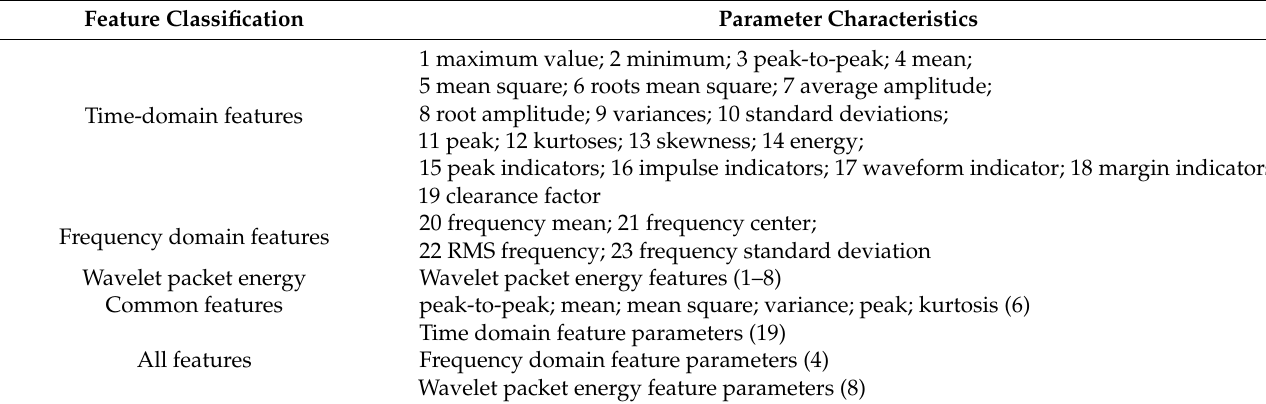
Table 1. The parameters of the fault